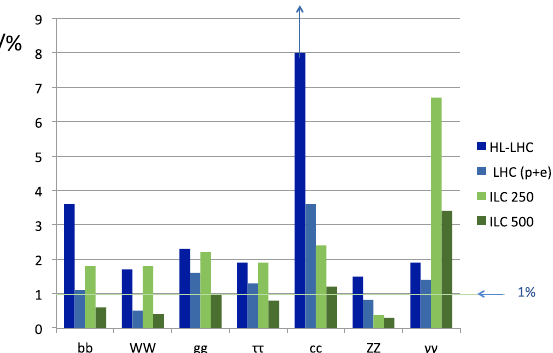
Fig. 3 Results of prospect evaluations of the determination of Higgs couplings in the SM kappa framework for HL-LHC (dark blue), LHC with LHeC combined (p+e, light blue), ILC 250 (light green) and ILC- 500 (dark green) [15]